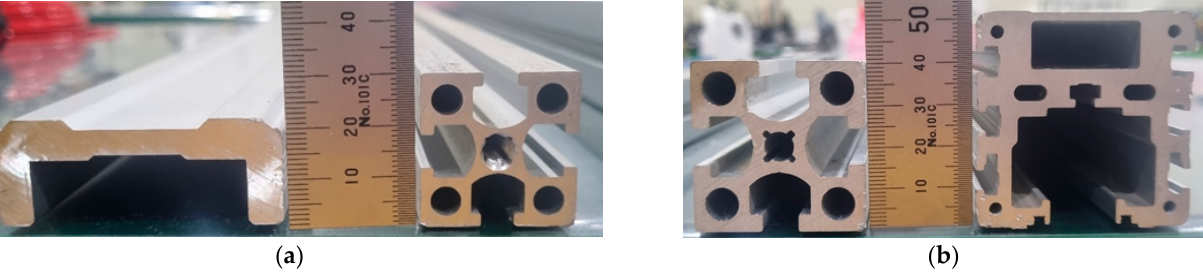
Figure 13. Photographs of the measurements of the prepared bumps. ( a ) 21 mm bump and 30 mm bump, ( b ) 40 mm bump and 51 mm bump.